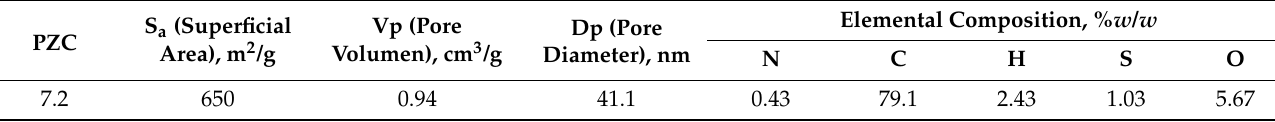
Table 7. Physicochemical properties and elemental analysis of PAC [45,46].